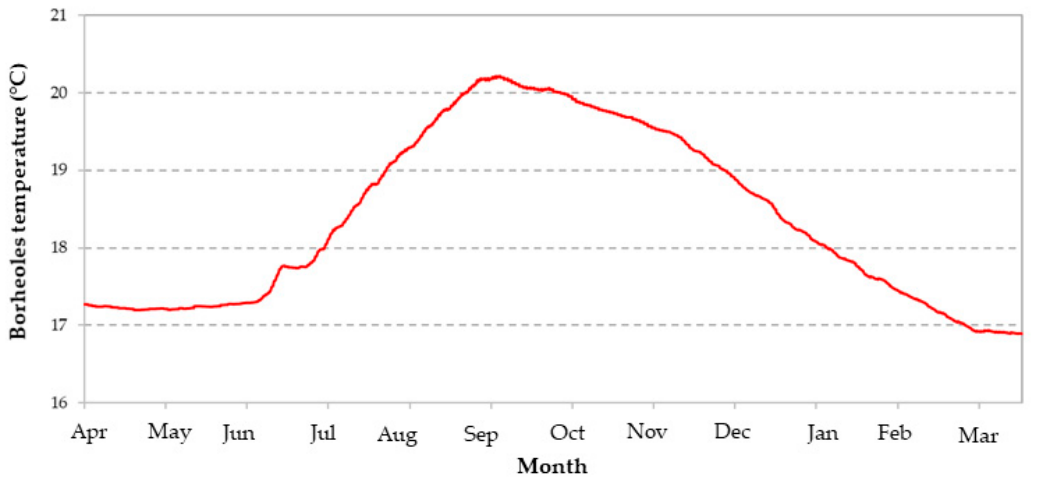
Figure 5. Simulated mean temperature of boreholes for one year.